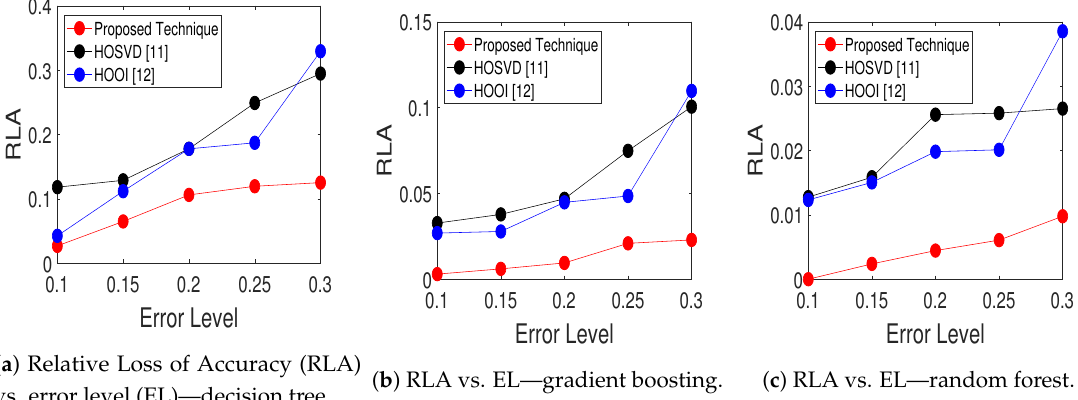
Figure 2. Plots of relative loss of accuracy, as a function of the error level, for the following machine learning (ML) classifiers: ( a ) decision tree, ( b ) gradient boosting, ( c ) random